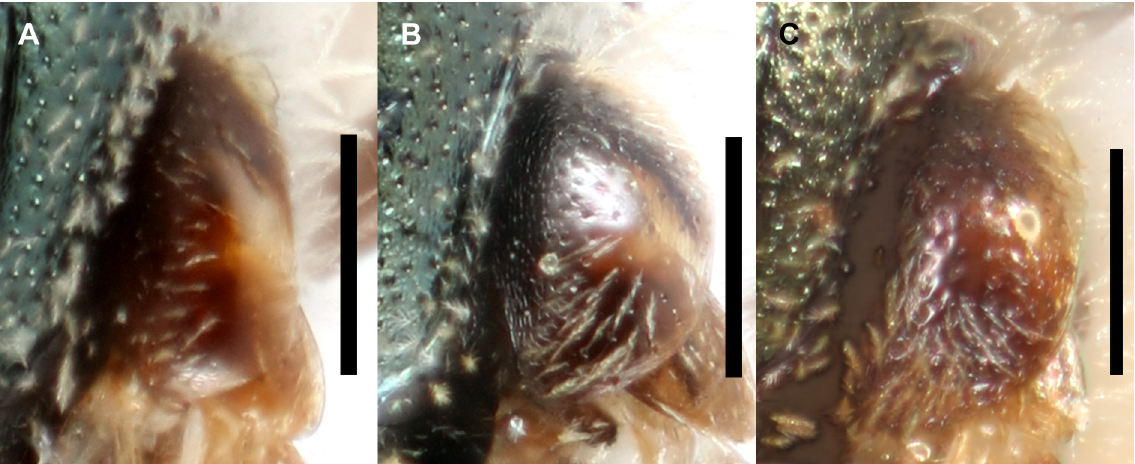
Fig. 81. Tegula. A . Lasioglossum profundum sp. nov., ♀, impunctate. B . L. holzenthali sp. nov., ♀, sparsely punctate. C . L. stictaspis (Sandhouse, 1923), ♀, densely punctate. Scale bars = 0.25